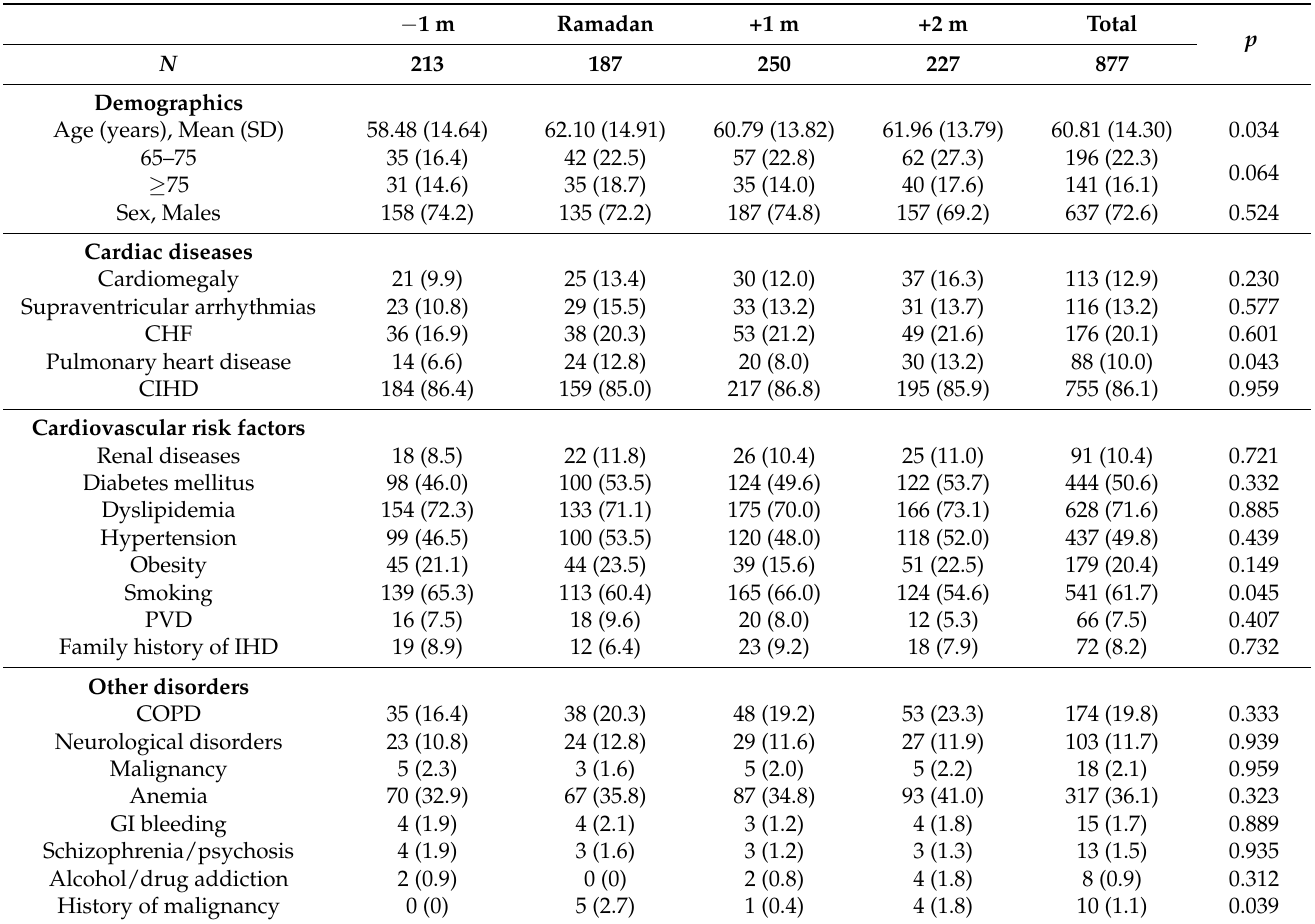
Table 1. Baseline Characteristics of the Muslim Study Population by Period. − 1